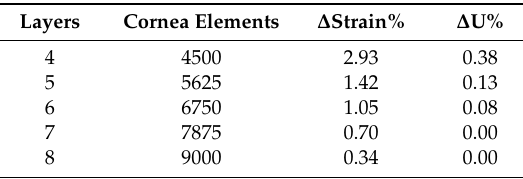
Table 1. Mesh convergence analysis. ∆ strain%: Percentage change in the highest maximum principal strain, ∆ U%: percentage change in highest maximum